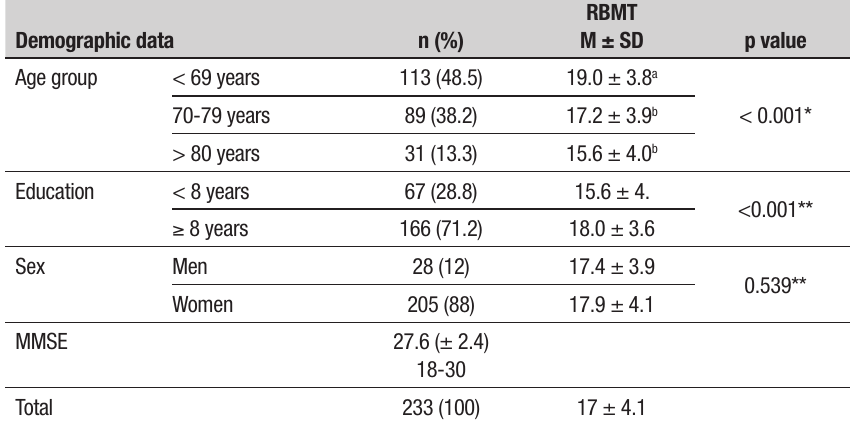
Table 1. RBMT scores according to sociodemographic characteristics.